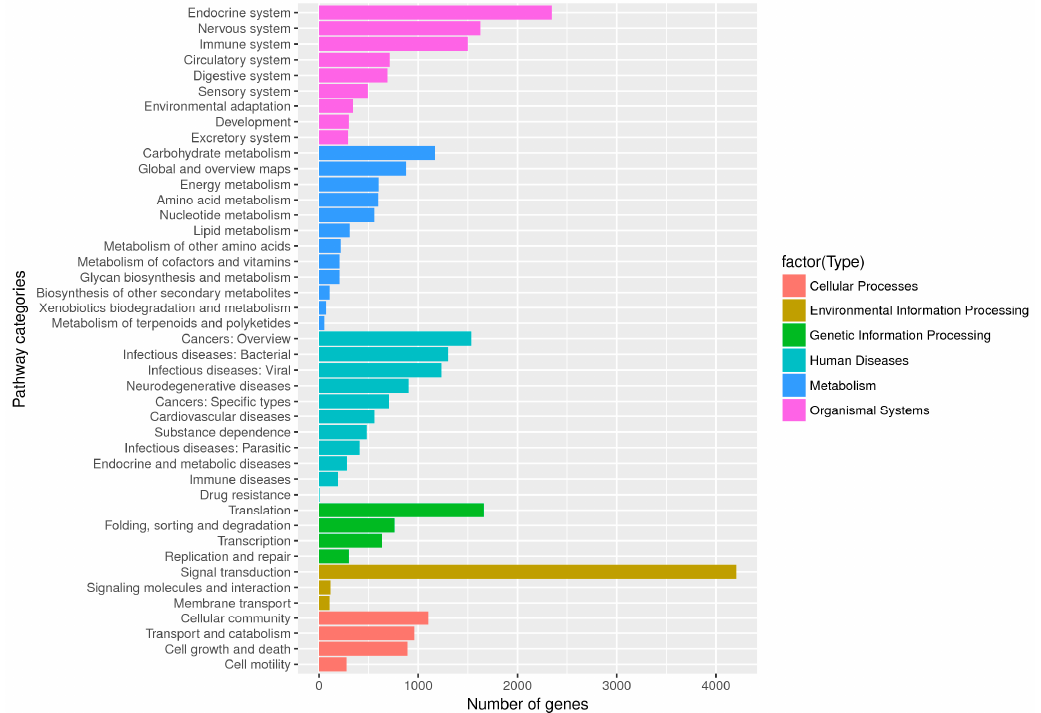
Figure 6. Kyoto Encyclopedia of Genes and Genome (KEGG) functional categories of the unigenes annotated in the current study. Unigenes were annotated and assigned to six main categories, cellular processes, environmental information processing, genetic information processing, human diseases, metabolism, and organismal systems.